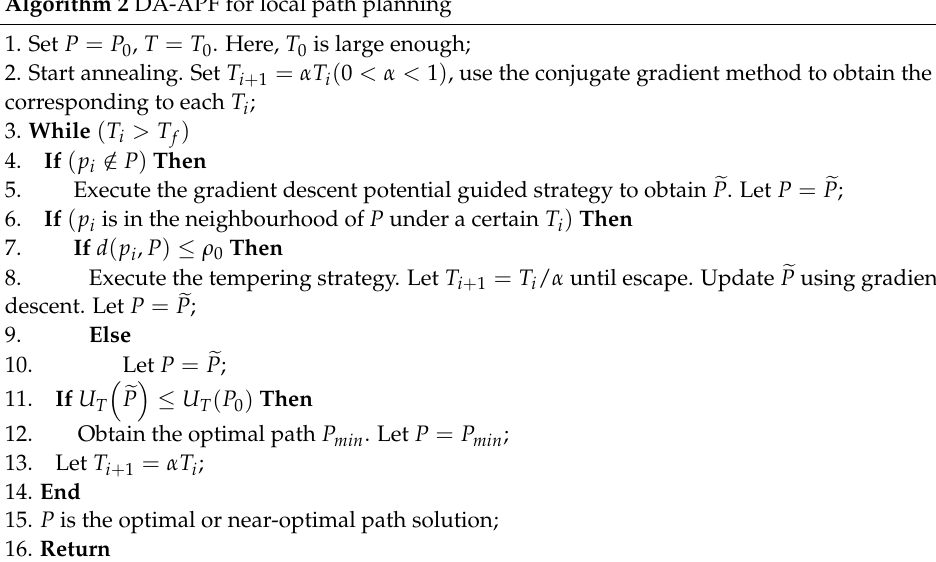
Algorithm 2 DA-APF for local path